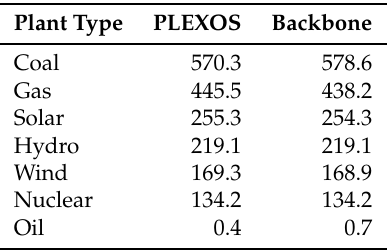
Figure 9. Hourly electricity production from day-ahead market simulation using ( a ) PLEXOS and ( b ) Backbone. Table 1. Total electricity production (GWh) from day-ahead market simulation, categorized by generator type.